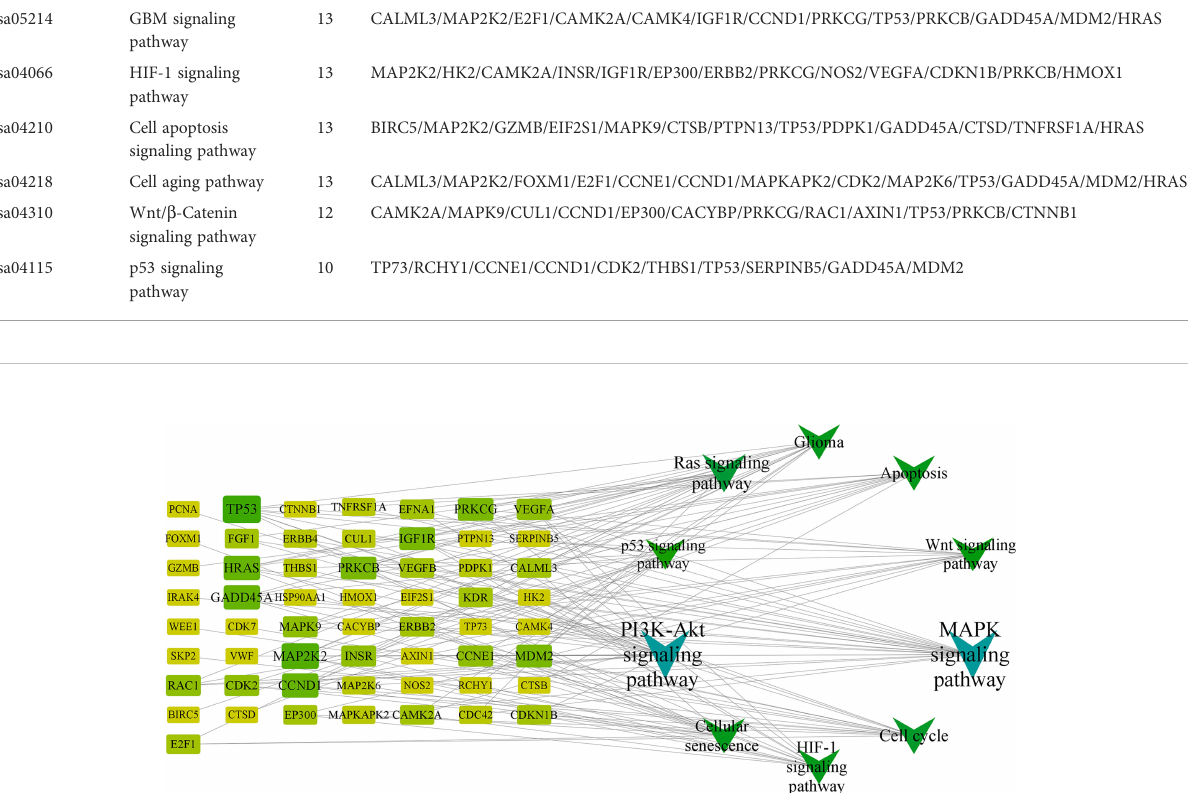
FIGURE 5 KEGG network chart of RXLD-related GBM